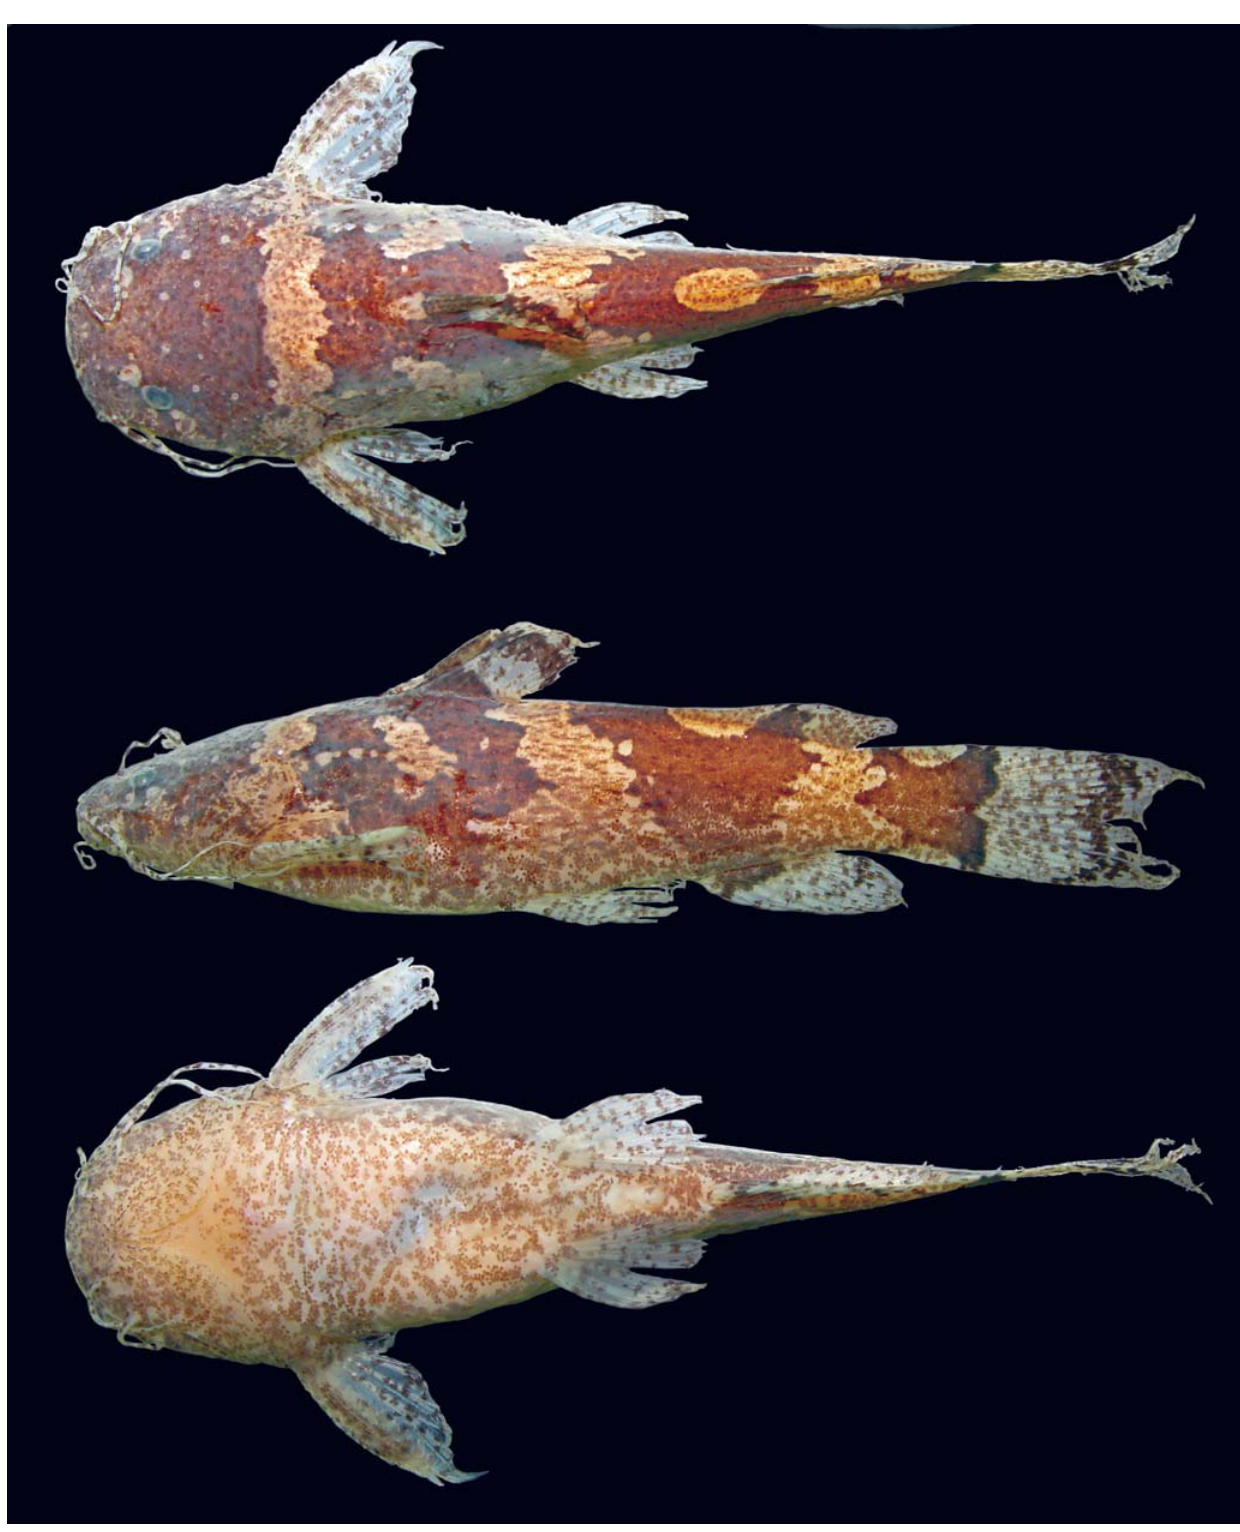
Fig. 1 . Microglanis carlae , holotype, MNHNP 3667, 32.5 mm SL, arroyo Yacaré, left bank tributary of río Tebicuary, río Paraguay basin,